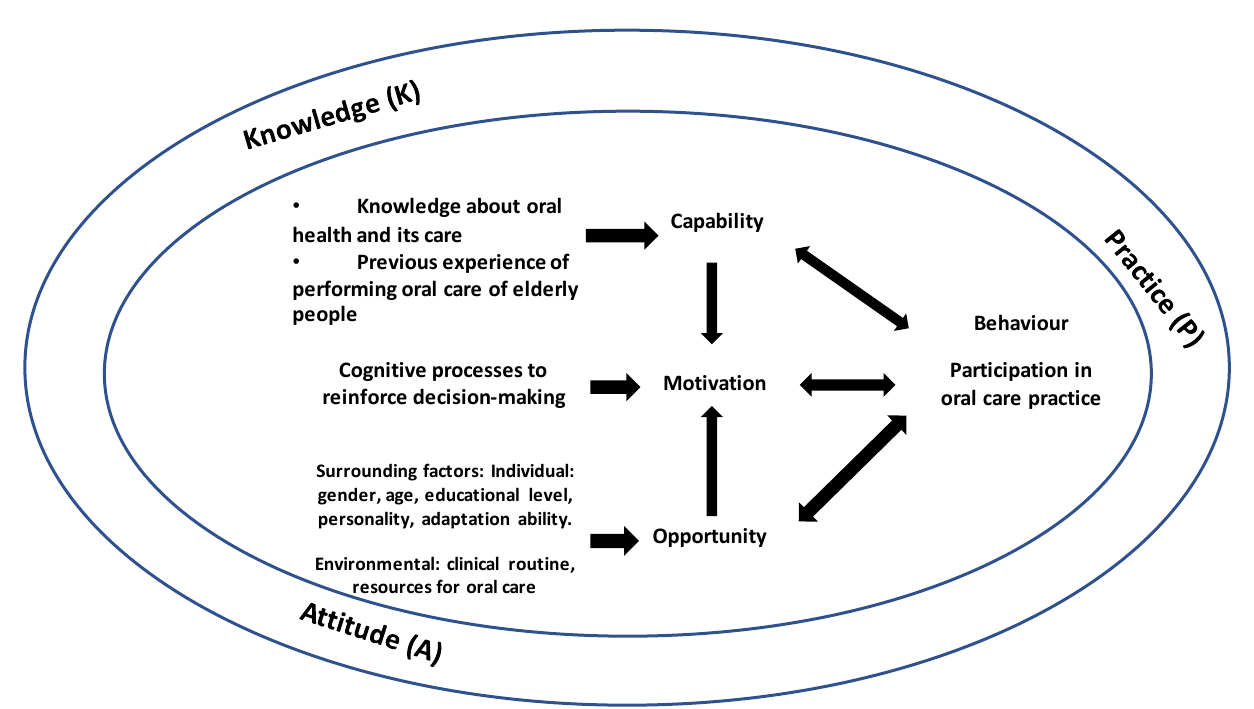
Figure 1. The Capability, Opportunity, Motivation Behavior (COM-B) Model and knowledge, attitude, and practice.